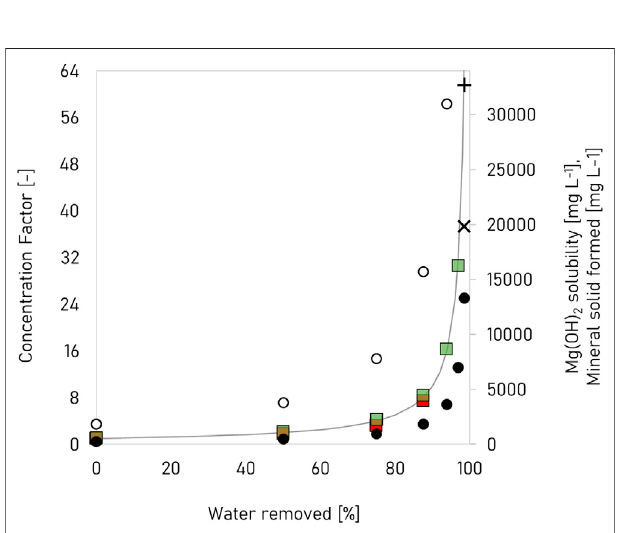
FIGURE 5 | The concentration factor ( - ) obtained as function of water removed (%) from urine. Shown on the secondary y-axis are simulated (green squares) and experimentally determined (red squares) solubility of Mg(OH) 2 , as well as the simulated amount of struvite ( ○ ), hydroxyapatite ( · ), halite (+) and arcanite ( ✕ ) that form in urine.